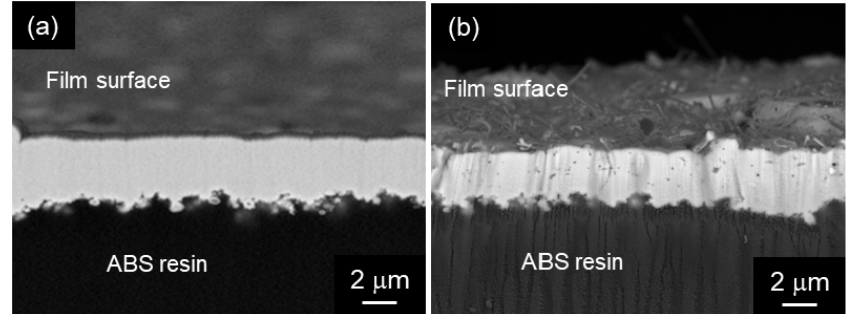
Figure 11. Cross-sectional SEM images of ( a ) electroless Ni-P alloy and ( b ) electroless Ni-P al- loy/MWCNT composite film on an ABS resin substrate. (Figure 11 is adapted from [117]).